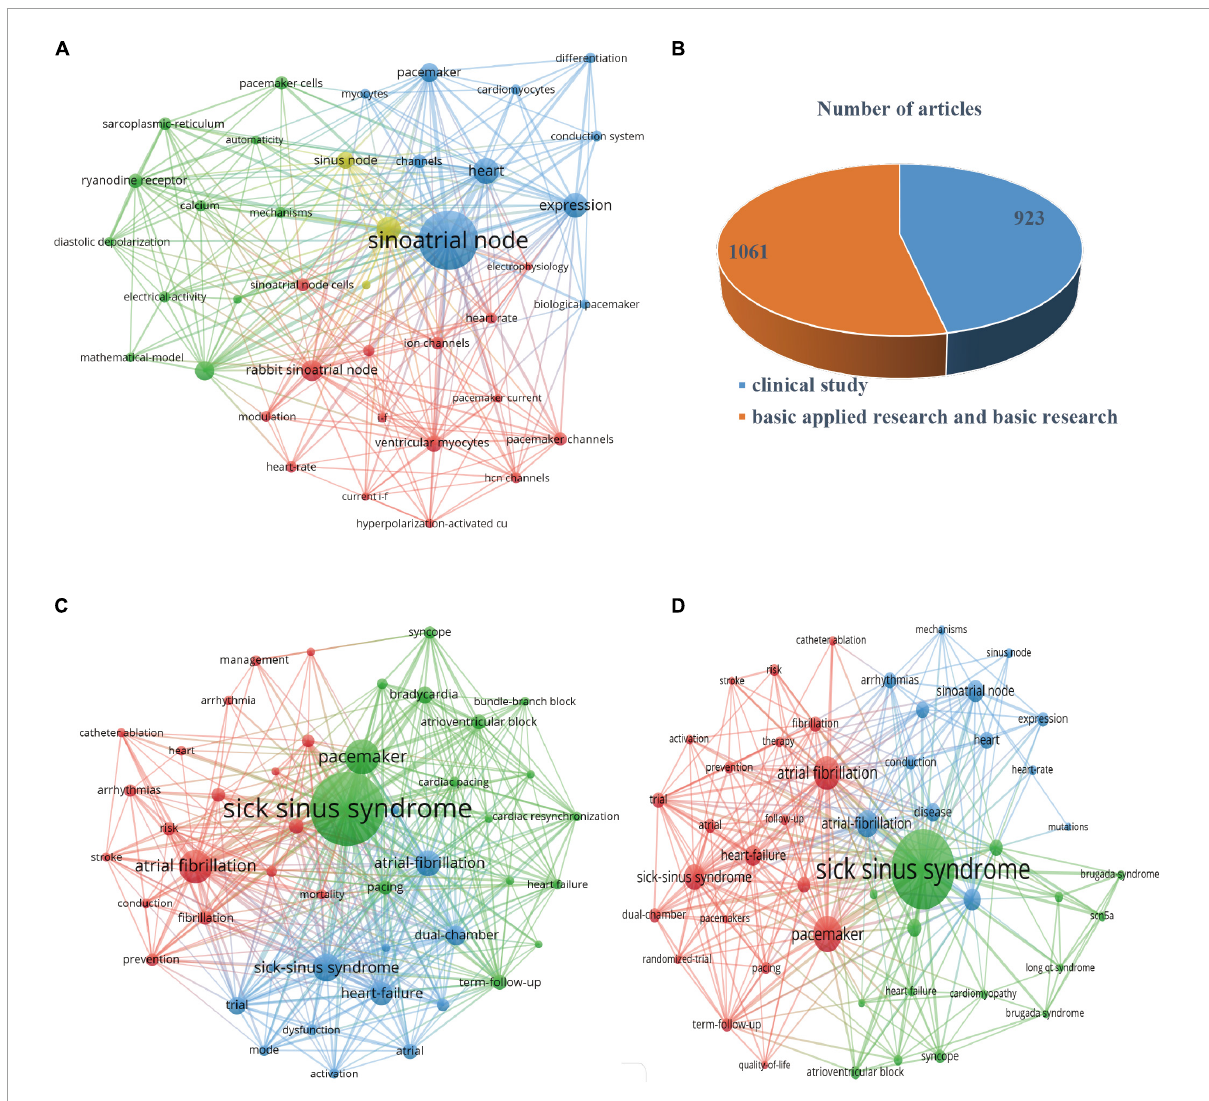
FIGURE7 (A) Network map of pacemaker cells isolated from the sinoatrial node based on VOS viewer. (B) Numbers of articles of clinical research, basic applied research and basic research on SSS. (C) Network map of clinical research on SSS based on VOS viewer. (D) Network map of basic applied research and basic research on SSS based on VOS